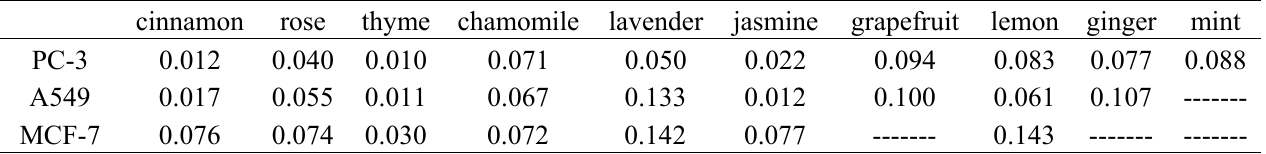
Table 2. Inhibition concentrations 50% (IC 50, %v/v) values for 10 essential oils of PC-3, A549 and MCF-7 cancer cell lines as determined by the MTT